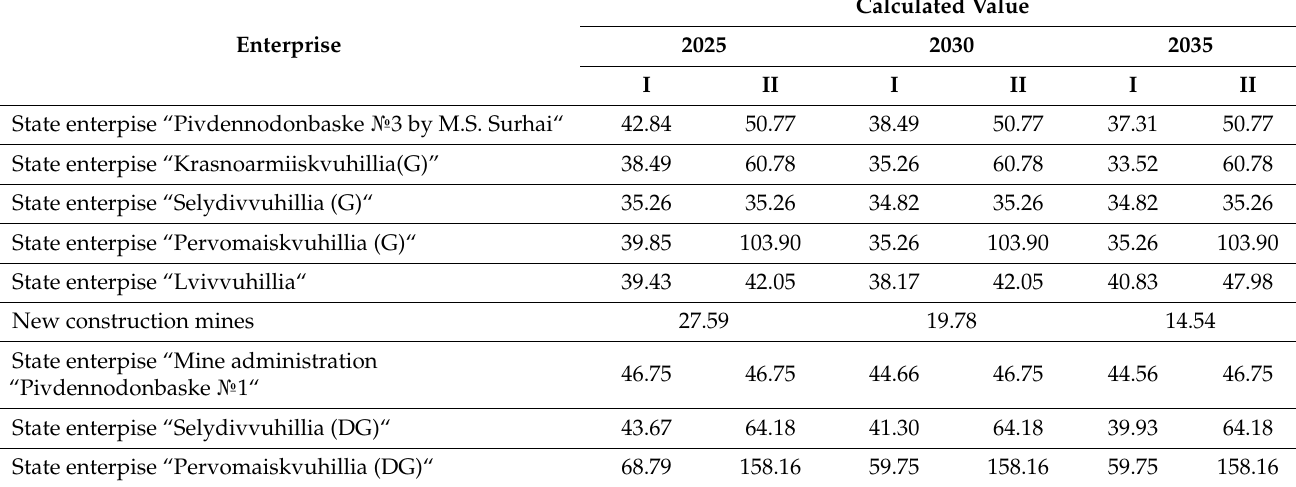
Table 1. The estimates for ready-to-use coal product prices for the period up to 2035,